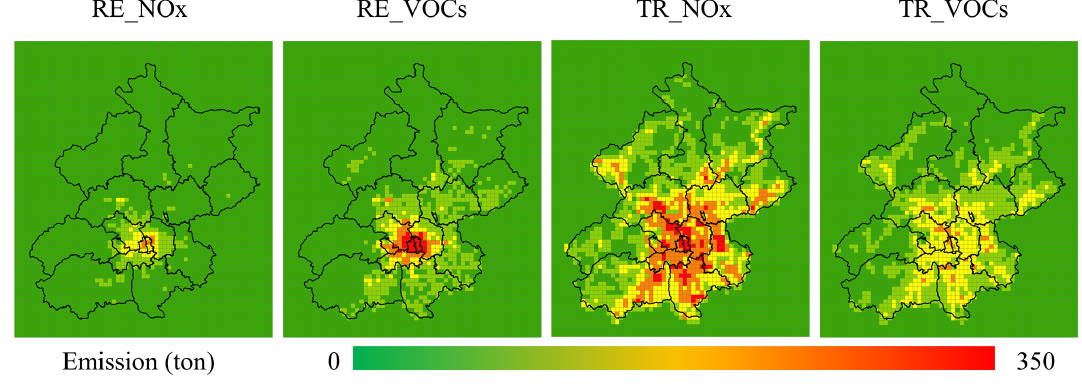
Figure 8. Spatial allocation for